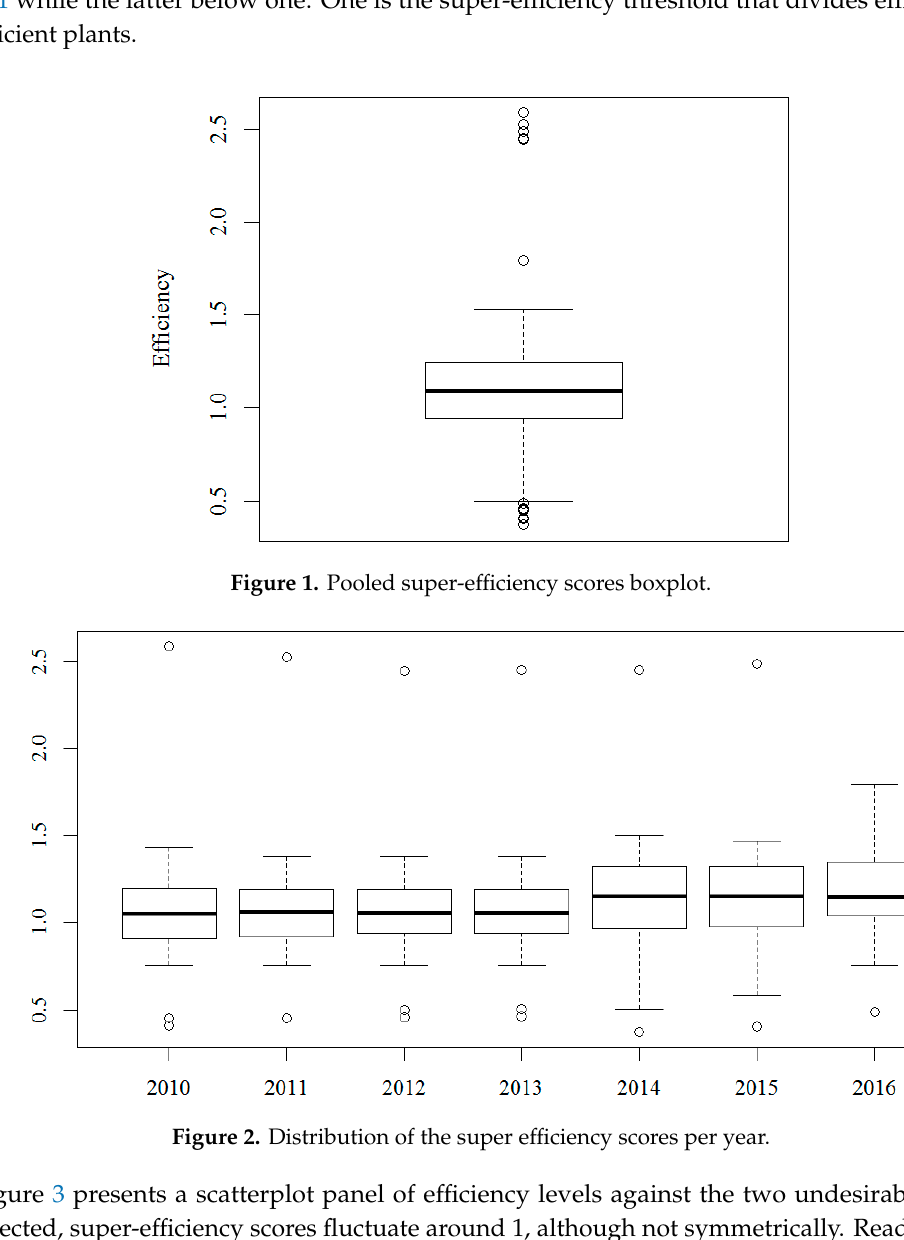
Figure 2. Distribution of the super efficiency scores per year.